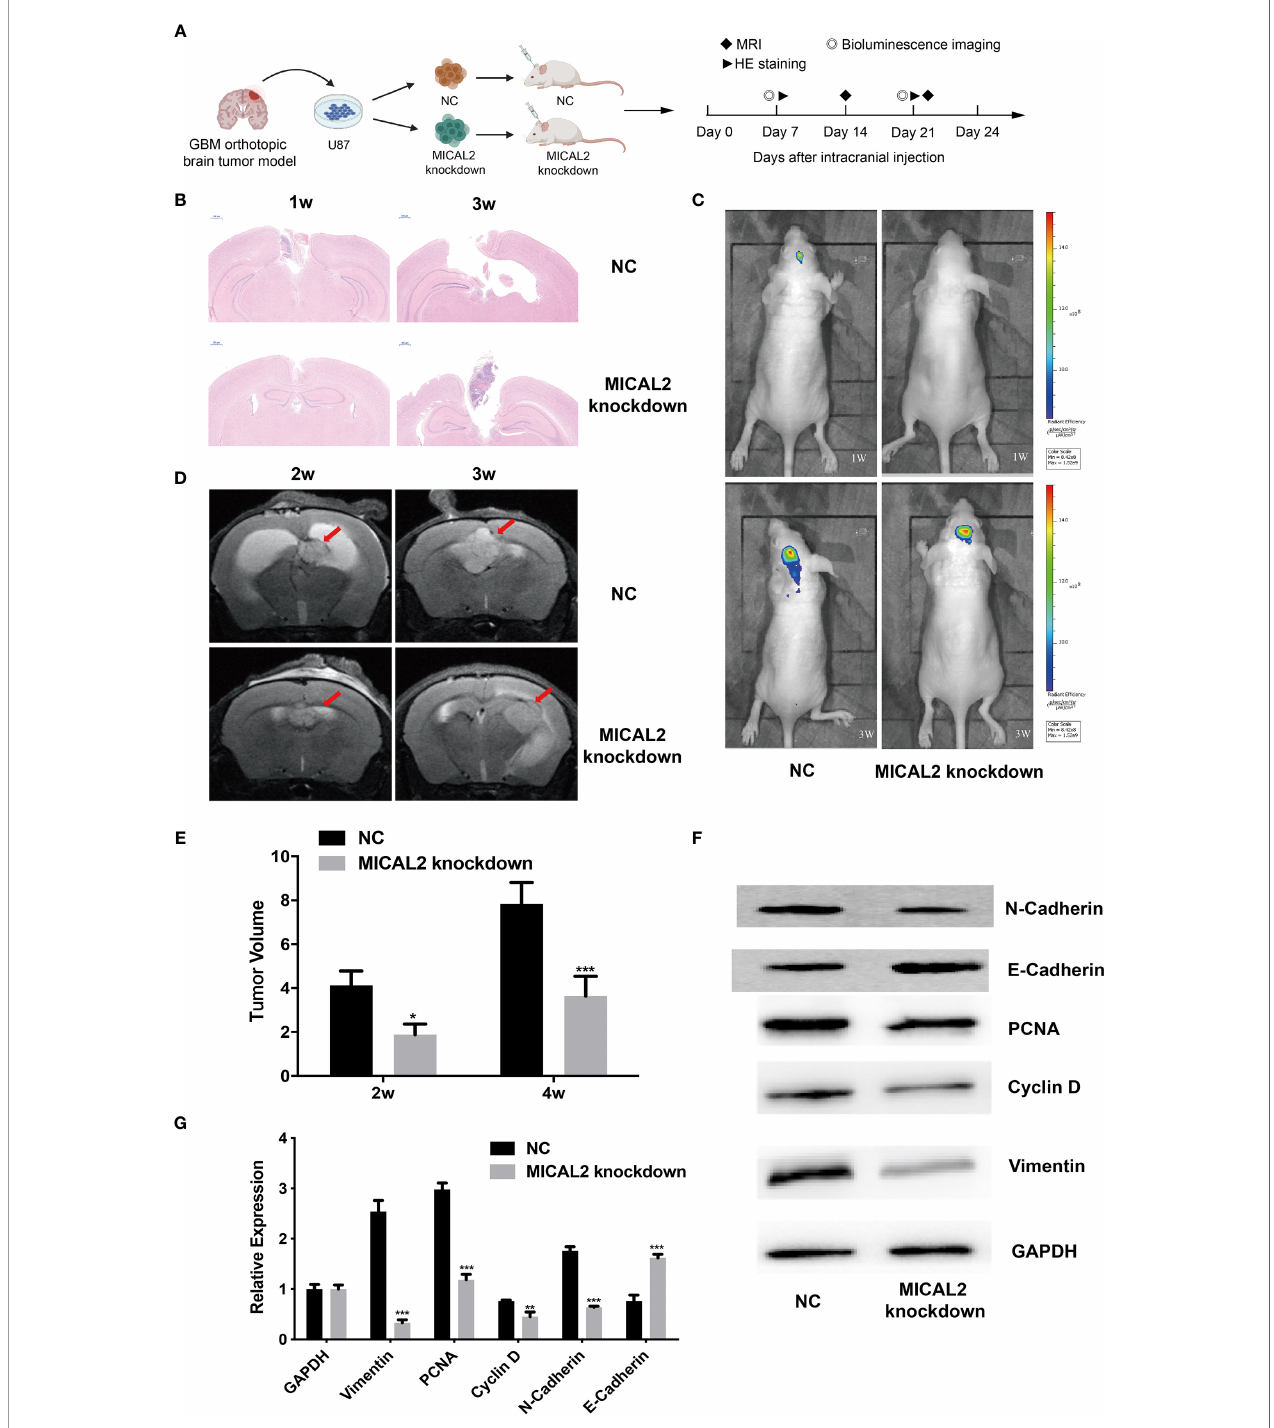
FIGURE 7 | MICAL2 promotes the proliferation of glioma cells in vivo . (A) Schematic of the MICAL2 knockdown and NC in patient-derived GBM orthotopic xenograft model (created with biorender.com) ( n = 15 for each group). (B) HE staining of orthotopic brain tumor. (C) Bioluminescence image of orthotopic brain tumor. (D, E) MRI image of orthotopic brain tumor, and the tumor size were analyzed. (F, G) PCNA, cyclin D, vimentin, N-cadherin, E-cadherin, and GAPDH expression detected by Western blotting. Data are shown as the means ± SEM of three experiments. *p < 0.05, **p < 0.01, ***p <